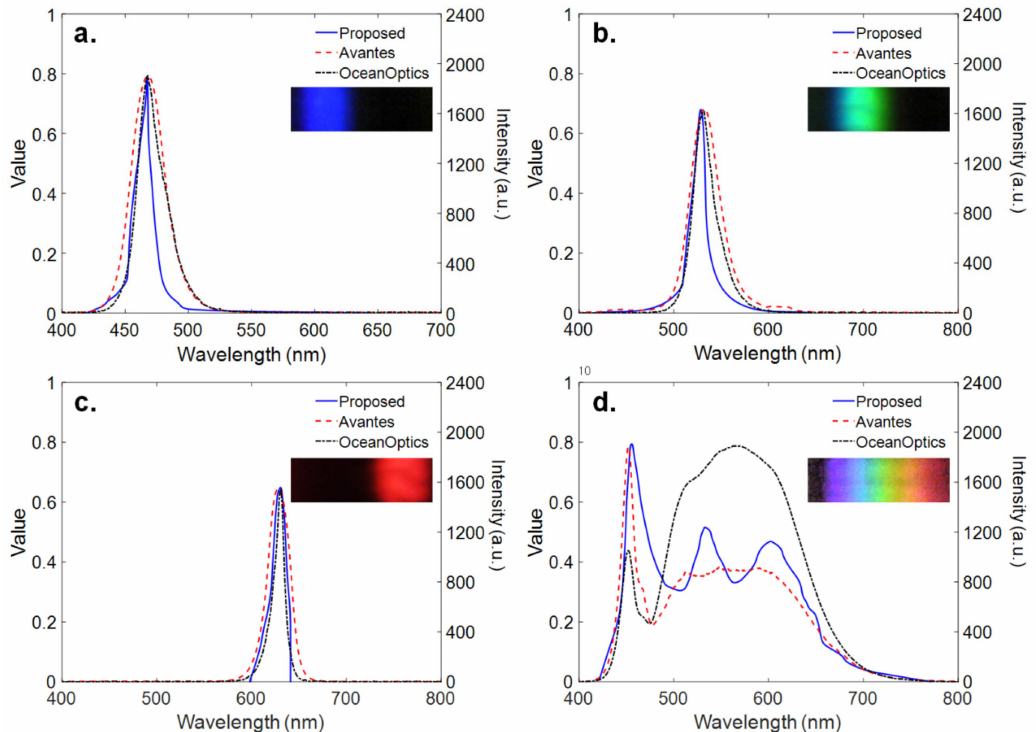
Figure 9. Spectrum for di ff erent visible light sources ( a ) blue, ( b ) green, ( c ) red, and ( d ) white. For more information, please refer to the Supplementary